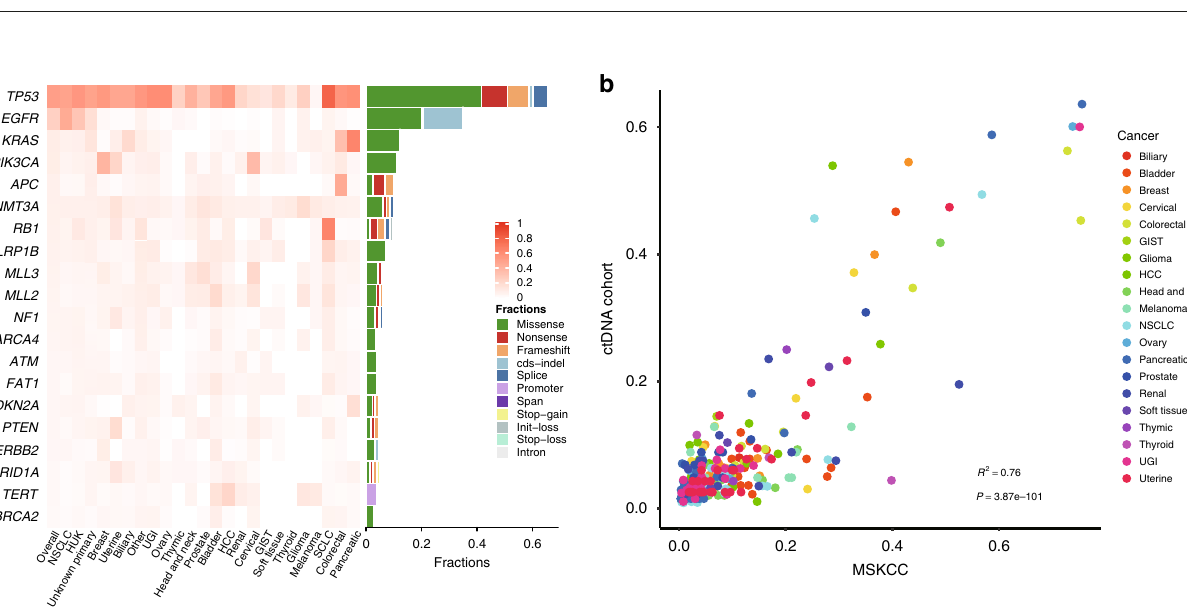
Fig. 2 Detectability of ctDNA in pan-cancer plasma. a Detection sensitivity of ctDNA in multiple cancer types. b AFs of ctDNA mutations varied across different cancer types. Median values are represented by black lines within the bars. For samples with multiple mutations, the highest AF is highlighted. Centre line, median; box limits, upper and lower quartiles; whiskers, 1.5× interquartile range; points, outliers. c Different cancer types showed different bTMB. Median values are represented by black lines within the bars. Centre line, median; box limits, upper and lower quartiles; whiskers, 1.5× interquartile range; points, outliers. d Density distribution of bTMB of all enrolled samples. Vertical solid and broken lines indicate the median and upper/lower quartile values, respectively. Based on the upper quartile of bTMB, the cut-off for high and low bTMB was set as 8.7 mutations/Mb. e Relative fractions of high and low bTMB samples in different cancer types. f Comparison of MATH values for different cancer types between our ctDNA and MSKCC cohorts (two-sided Mann – Whitney U test). The bottom red and green numbers indicate the sample sizes of corresponding tumor subtypes in the ctDNA cohort and MSKCC, respectively. Median values are represented by black lines within the bars. Centre line, median; box limits, upper and lower quartiles; whiskers, 1.5× interquartile range; points, outliers. AF allele frequency, bTMB blood tumor mutational burden, GIST gastrointestinal stromal tumor, HCC hepatocellular